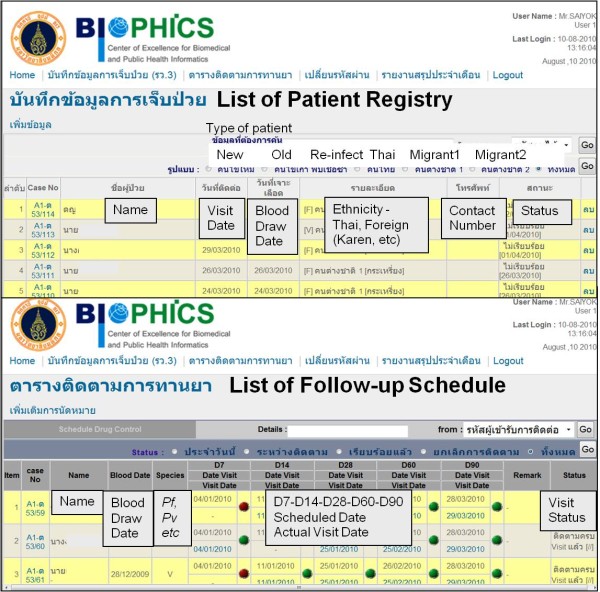
Screen shots of case registry and follow-up schedule.